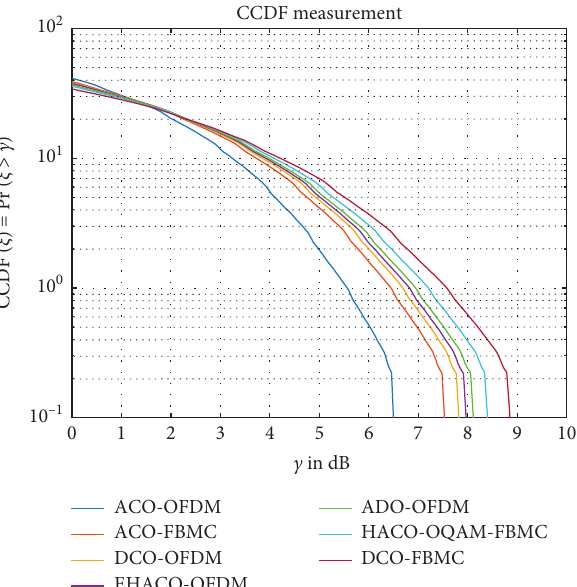
Figure 8: Simulation of peak to average power ratio (PAPR) of ACO-OFDM, ACO-FBMC, DCO-OFDM, EHACO-OFDM, ADO- OFDM, DCO-OFDM, and